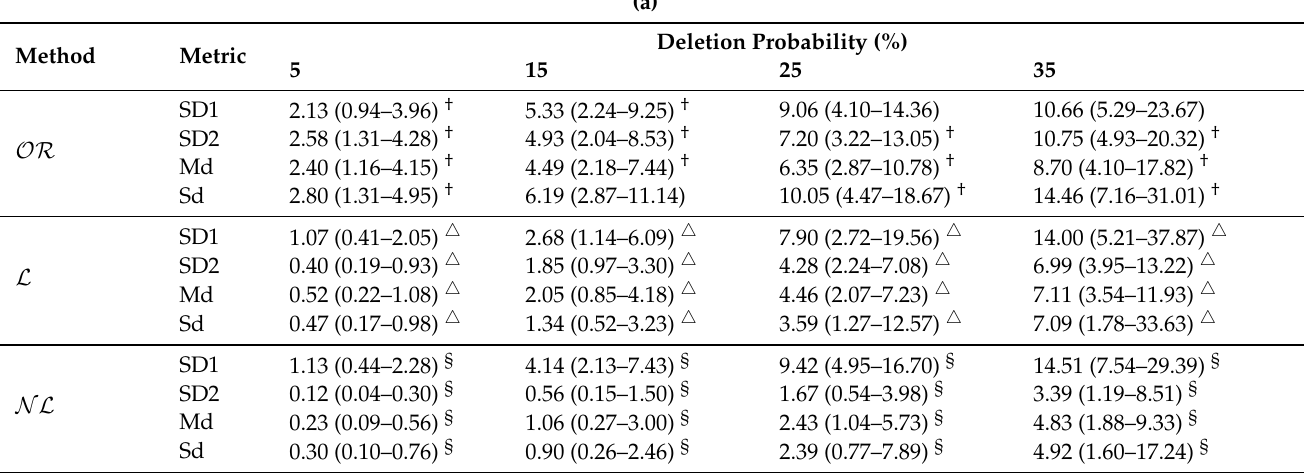
Table 10. Relative error (%) of Poincaré metrics. (a) Scattered missing beats. (b) Bursts. †: Significant differences ( p < 0.05) between OR and L . (cid:52) : Significant differences ( p < 0.05) between L and N L . §: Significant differences ( p < 0.05) between N L and OR